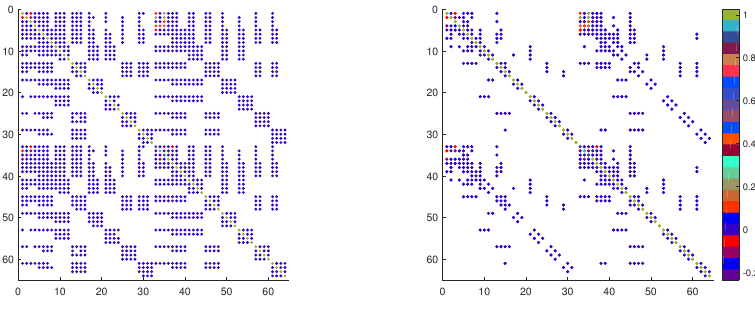
Figure 4. Plot of sparse matrix after thresholding with ε = 10 − 5 ( left ) and ε = 10 − 3 ( right ) for Example 2.